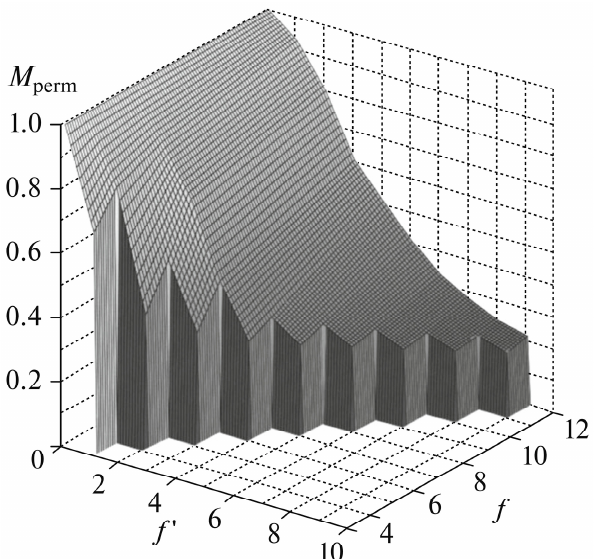
Figure 9. Dependency of the permissible torque M perm on the total number of phases of the power circuit diagram f and on the number of failed phases f ’.